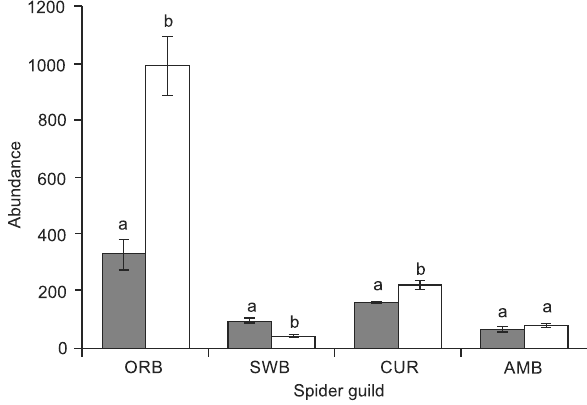
Figure 6. Spider abundance (adults and juveniles) for each of four feeding guilds in rice fields with and without insecticide (CUR, cursorial hunters; AMB, ambushing hunters; ORB, orbicular web builders; SWB, sheet web builders) (letters indicate significant dif- ferences, p < 0.05). ( (cid:133) ) Control, ( (cid:132) )